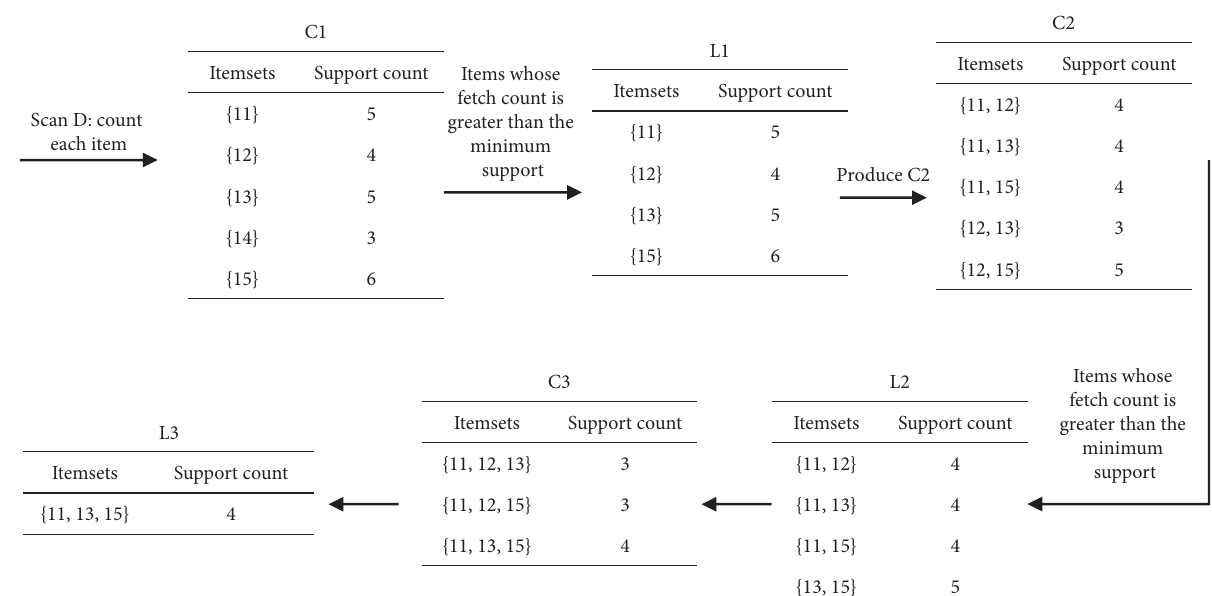
Figure 1: The execution process of Apriori algorithm.